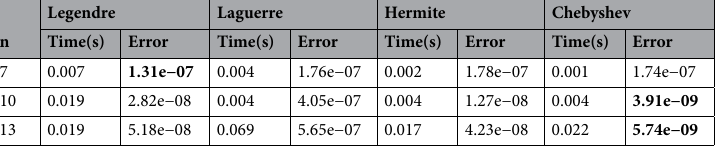
Table 14. Comparision of maximum relative error of z 3 ( t ) for Example 7.3 with different numbers of neurons. Significant values are in bold.